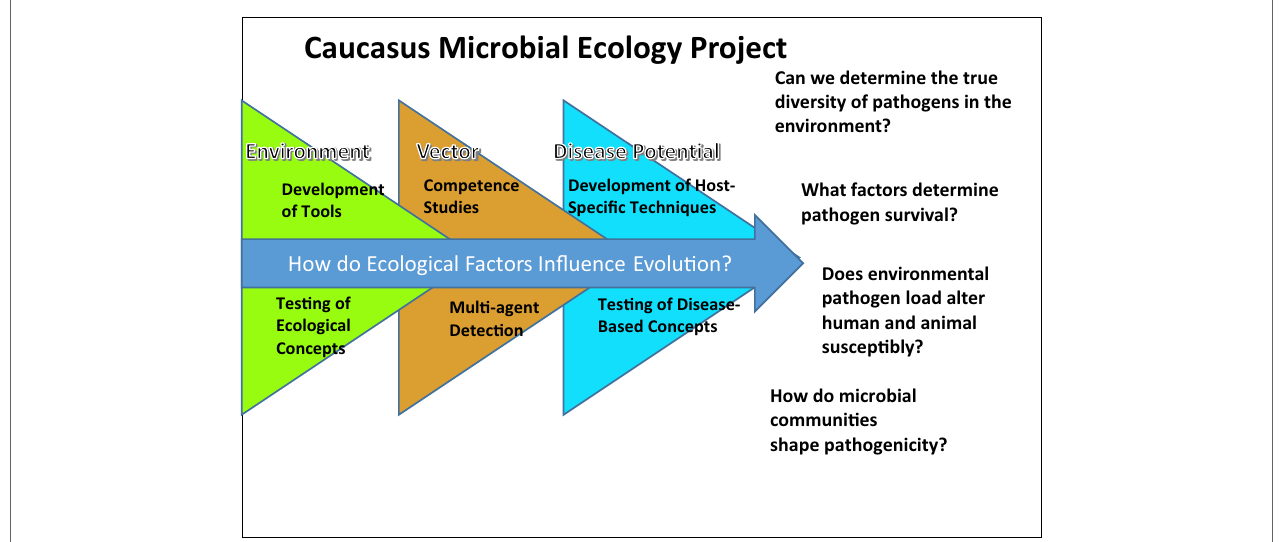
FiGURe 1 | Microbial ecology and evolution of pathogens in the Caucasus – Study Plan